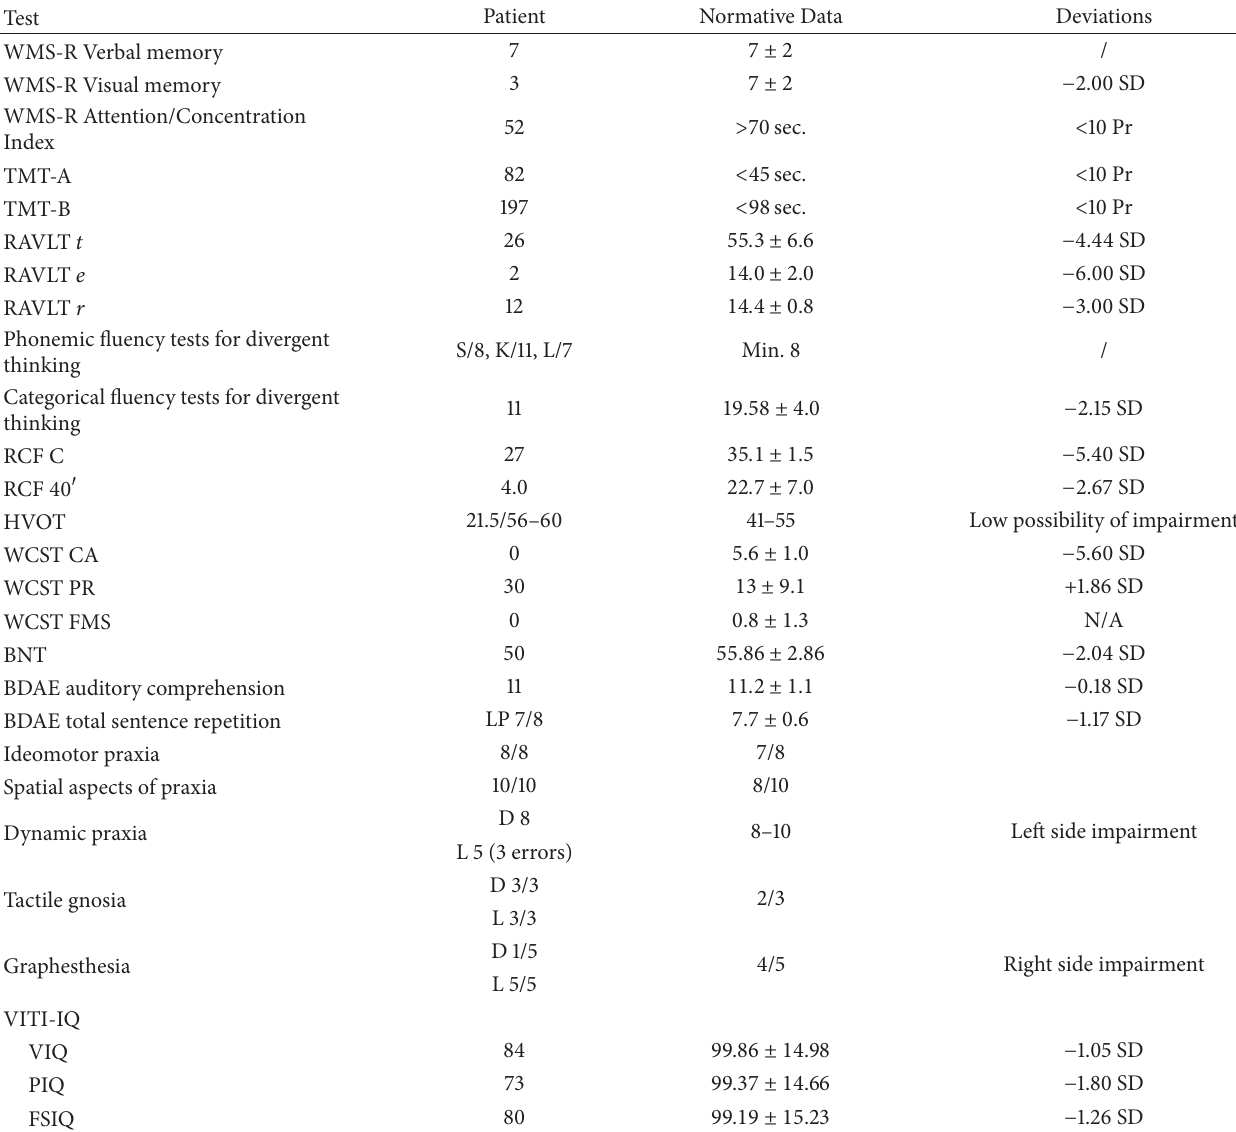
Table 1: Neuropsychological